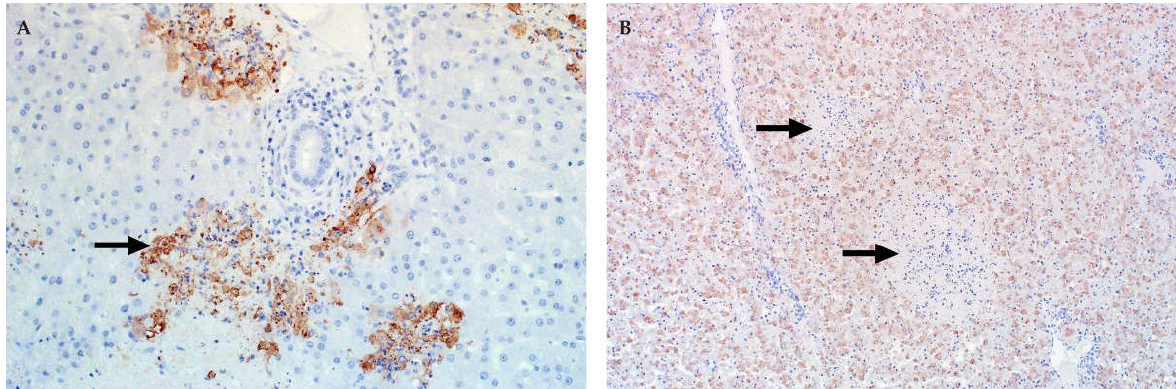
Figure 5. Immunolabelling for RVFV in the liver of sheep (polyclonal mouse anti-RVFV nucleoprotein antibody, avidin- biotin-peroxidase detection system, NovaRED chromogen and haematoxylin counterstain). ( A ) In this specimen from an adult sheep, viral antigen (arrow) is present in multiple foci in the lobule. Labelling is present in the cytoplasm of injured hepatocytes and is diffuse or fine granular, mag 400×. ( B ) In young lambs, viral antigen is diffusely present in the cytoplasm of hepatocytes, but labelling is sparse in primary foci (arrows), mag 100×.